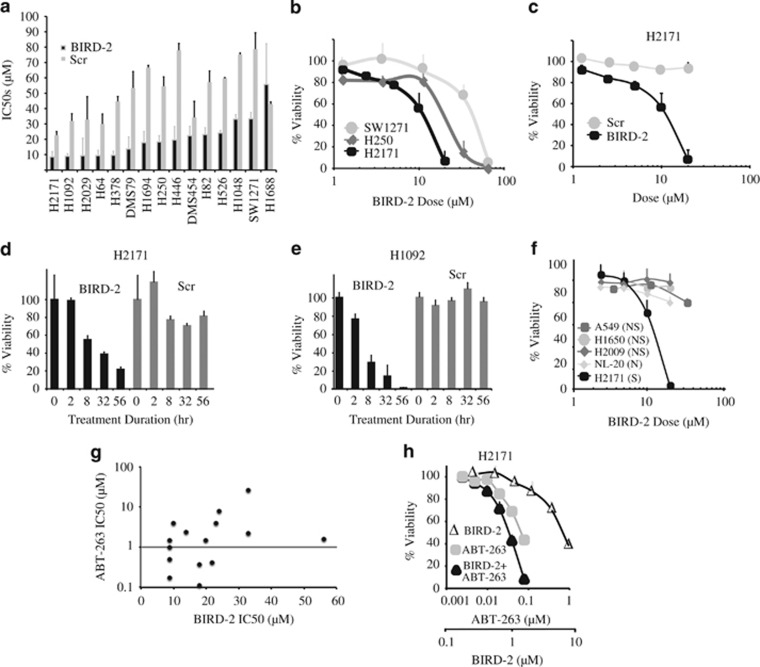
Cell death induction by BIRD-2. (a) IC50s of BIRD-2 and Scr control peptide (scrambled version of BIRD-2) in SCLC lines treated for 48 h with a broad range of peptide concentrations. Full dose–response curves were repeated at least three times. (b) Representative dose–response curves of SCLC lines treated for 48 h with BIRD-2. (c) Representative dose–response curves comparing H2171 cells treated for 48 h with BIRD-2 or Scr. (d and e) Time course of cell death induction by BIRD-2 in SCLC lines treated with 15 μM (H2171) or 20 μM (H1092) BIRD-2 or Scr at corresponding concentrations. (f) Dose–response curves comparing BIRD-2 sensitivity in SCLC cells (S), NSCLC cells (NS), and normal lung epithelial cells (N), each treated for 24 h with BIRD-2 at the indicated concentrations. (g) Graph based on data in Supplementary Table S1 comparing IC50s for BIRD-2 and ABT-263; each symbol represents an individual SCLC line. The horizontal line corresponds to an ABT-263 IC50 of 1 μM. (h) H2171 cells were treated for 48 h with variable concentrations of BIRD-2, ABT-263, or 127 : 1 BIRD-2+ABT-263 (BIRD-2 IC50 to ABT-263 IC50 ratio of 127 : 1). Cell viability was measured by CTG assay